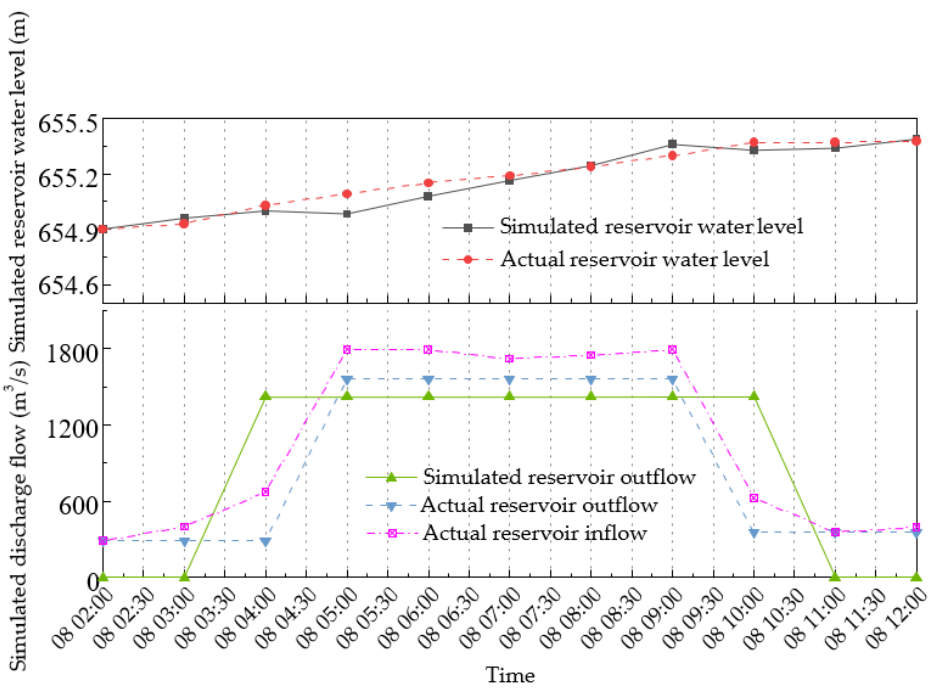
Figure 8. Comparison of water level and outflow discharge between simulated results and actual process under Condition C3.